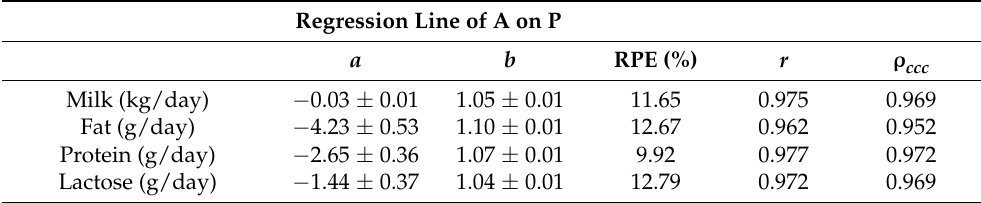
Table 3. Measures of goodness of fit of the model of the lactation curves for milk and lactose using random regression with a fourth-order Legendre polynomial and for fat and protein using random regression with a fifth-order Legendre